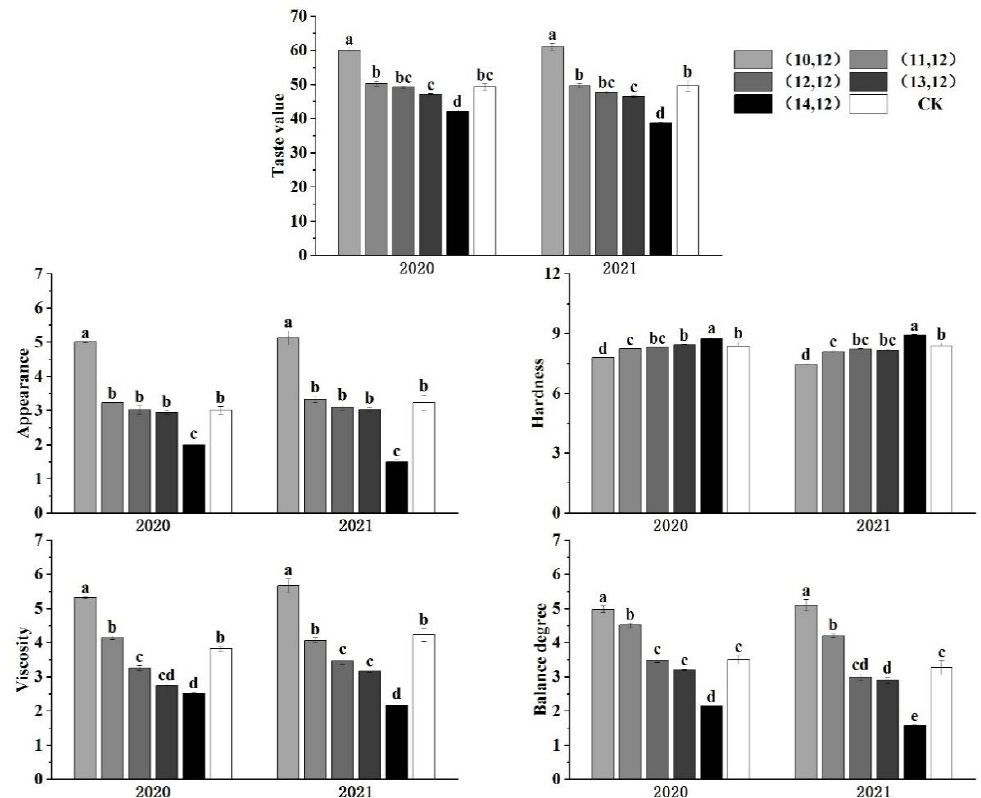
Figure 6. Effects of N and K application on cooking quality under different leaf age patterns in 2020 and 2021, with the results of the two-factor ANOVA. The (10, 12), etc., represent the patterns of different applications of N and K at the panicle stage; CK is the fertilization pattern of local farmers. Error bars indicate standard errors of three replicates. Different lowercase letters above the columns indicate significant differences ( p < 0.05) among different panicle fertilizer application patterns in the same year. Table 6. Effects of different N and K combined application rates during the panicle stage on cooking quality in 2020 and 2021, with the results of the three-way ANOVA. Balance Year Treatment Appearance Hardness Viscosity Degree